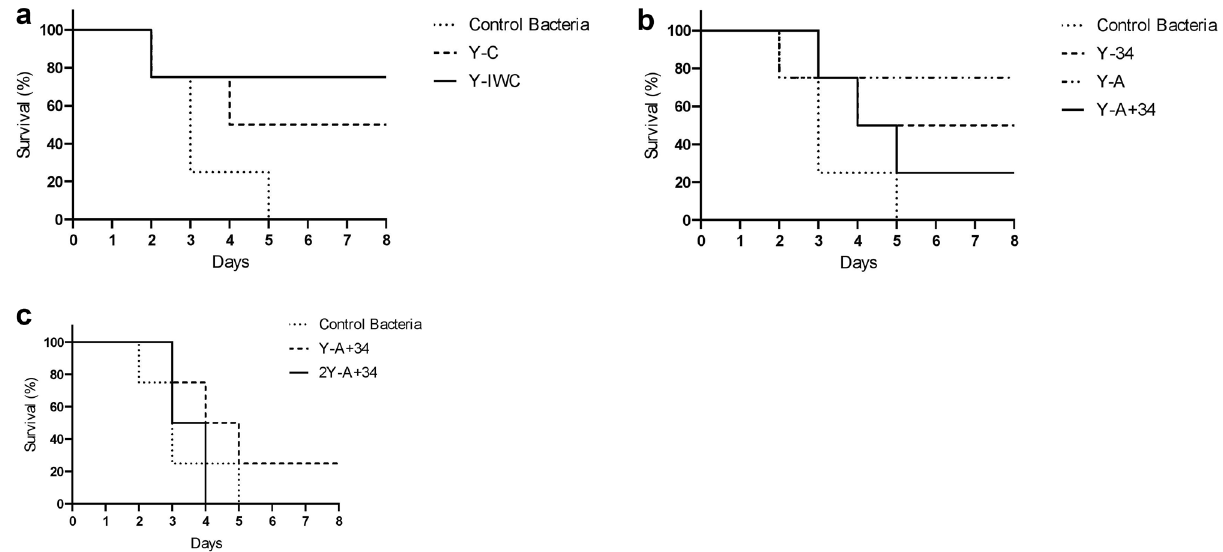
Figure 6. Survival plots of mice treated with specific IgYs 4 h after challenge with A.baumannii AbI101 suspended in PBS compared to the control group receiving 5.65 × 10 8 CFU of A. baumannii AbI101. a Y-C: Mice receiving 40 µg of IgY-C after challenge with the bacteria. Y-IWC: Mice receiving 40 µg of IgY-IWC after challenge with the bacteria. b Y-34: Mice receiving 40 µg of IgY-34 after challenge with the bacteria. Y-A: Mice receiving 40 µg of IgY-A after challenge with the bacteria. Y-A + 34: Mice receiving 40 µg of IgY-A + 34 after challenge with the bacteria. c Y-A + 34: Mice receiving 40 µg of IgY-A + 34 after challenge with the